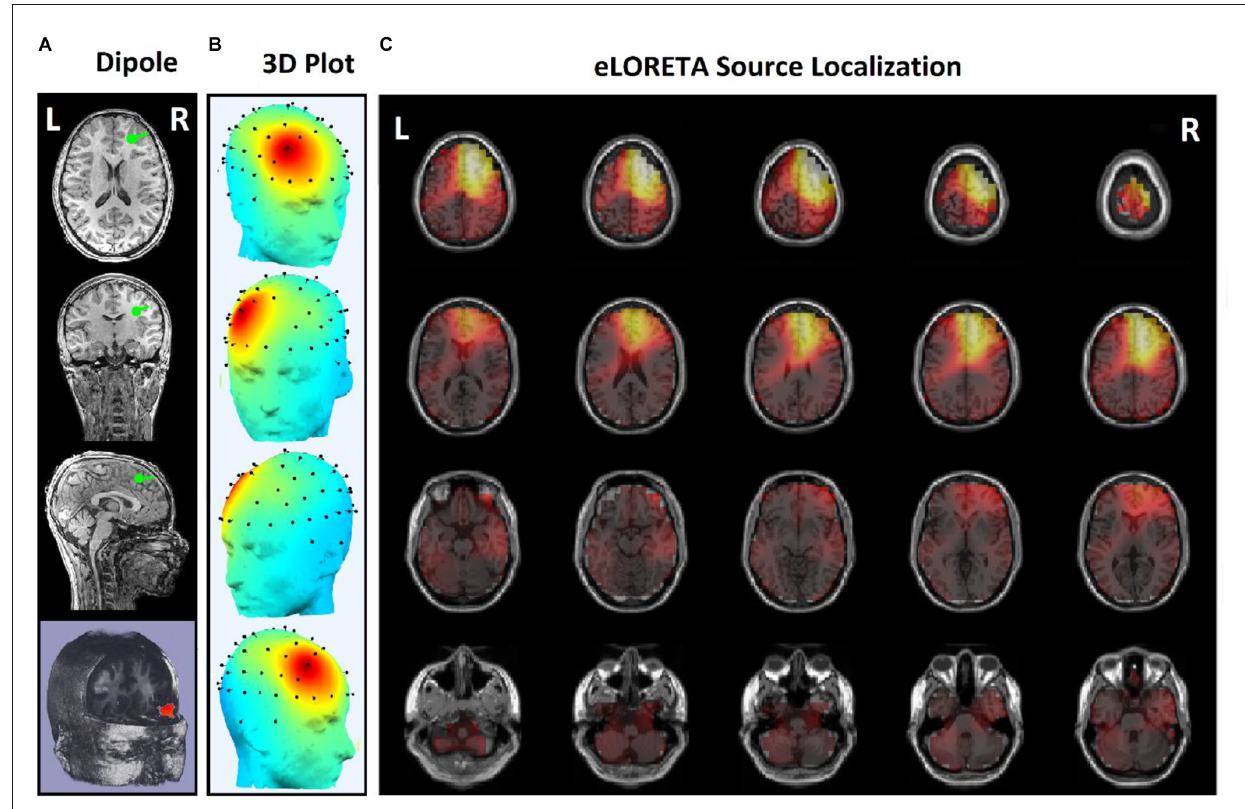
FIGURE6 Source localization of rTMS stimulation foci in right prefrontal cortex (R-DLPFC) for a non-responder subject. (A) Dipole coordinates of the identified focus in right side on a default MRI. (B) Position of the foci identified by ICA on the surface of the skull. (C) Source localization in right DLPFC by